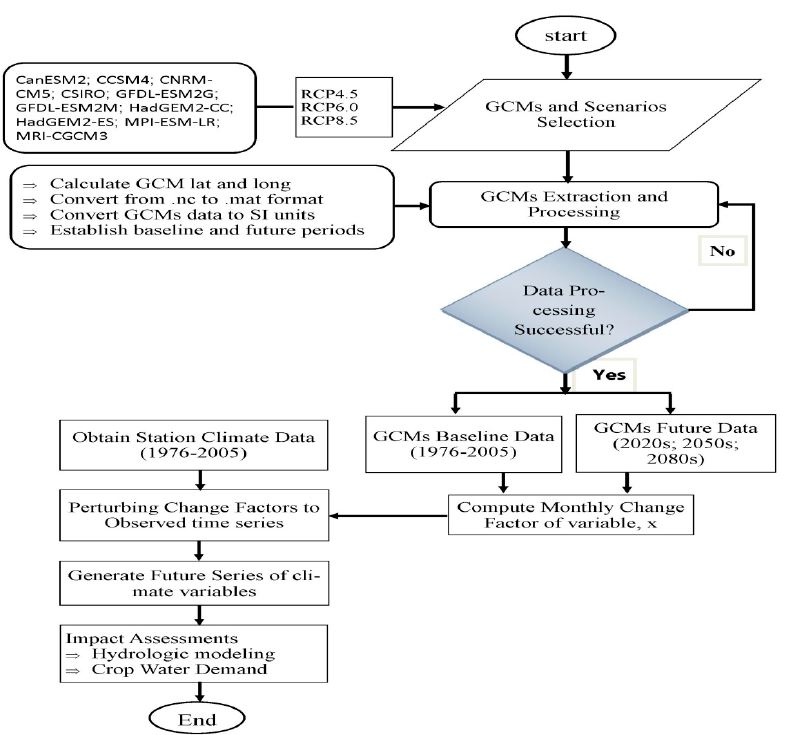
Figure 6. Schematic flowchart for the simulation of climate sequences in the hydro-meteorological interface under climate forcing.